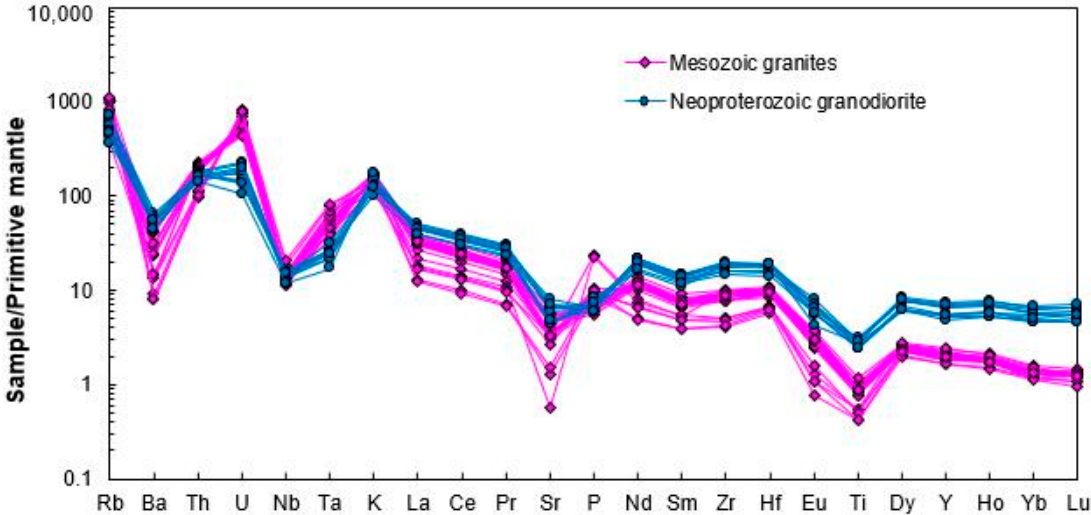
Figure 6. Primitive mantle-normalized multi-element diagrams of the Shimensi granodiorite. Normalization values are from Sun and McDonough [41]. Data of the ore-related Mesozoic Shimensi granites are from Wei et al. [6].